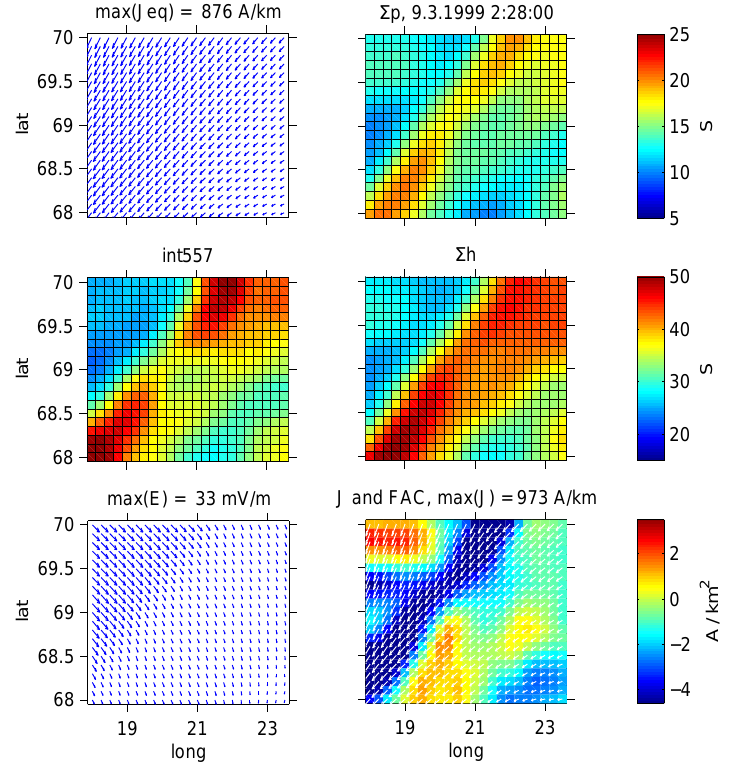
Fig. 10. Similar to Fig. 7, but for